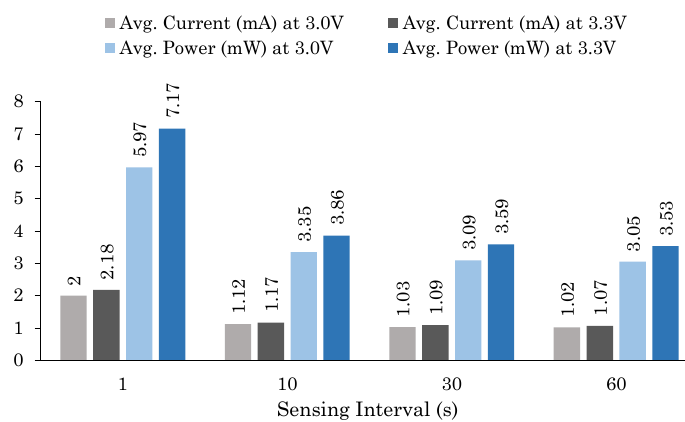
Figure 8. Average current (mA) and average power (mW) consumed by the prototype parking sensor node at different voltage levels and sampling